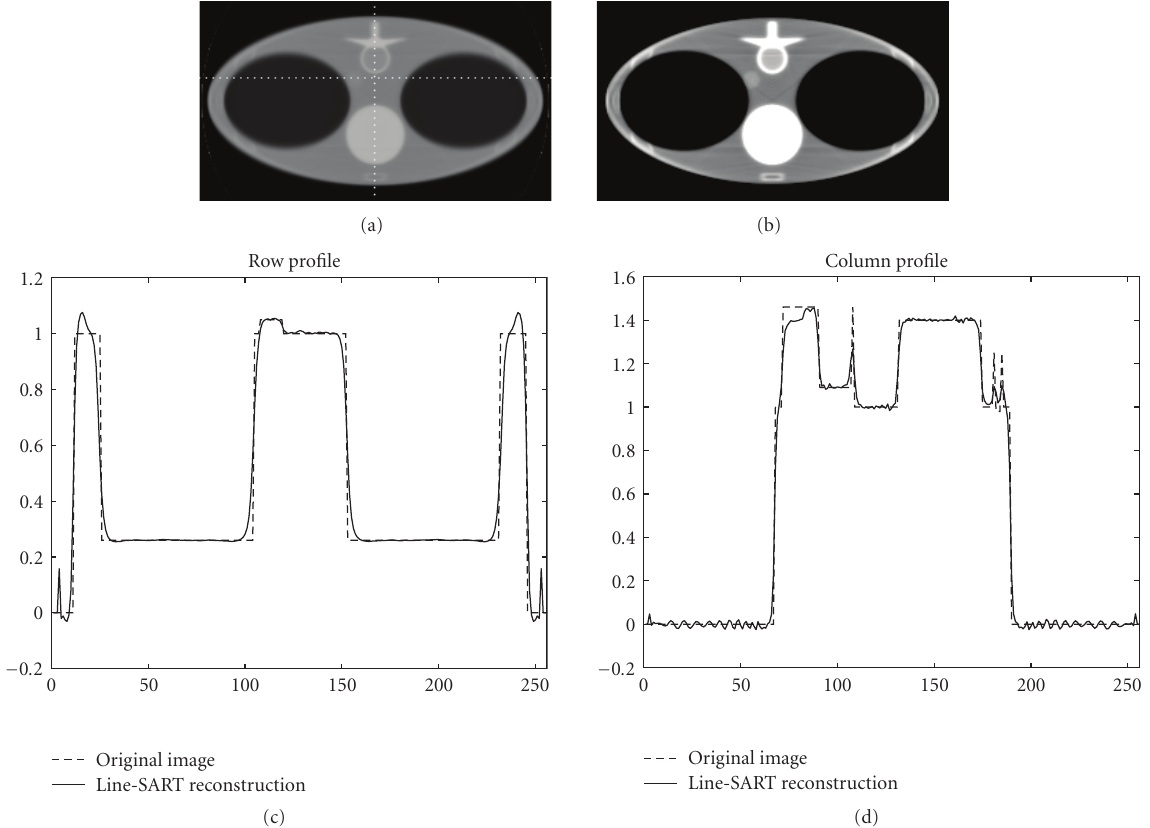
Figure 4: Line SART reconstructed images after 100 iterations using a line source of length 5cm at two di ff erent display windows with profiles along the dotted line. (a) Reconstructed image at a display window of [0,2]. (b) Reconstructed image at a display window of [0 . 8,1 . 2]. (c) Profile of the row. (d) Profile of the